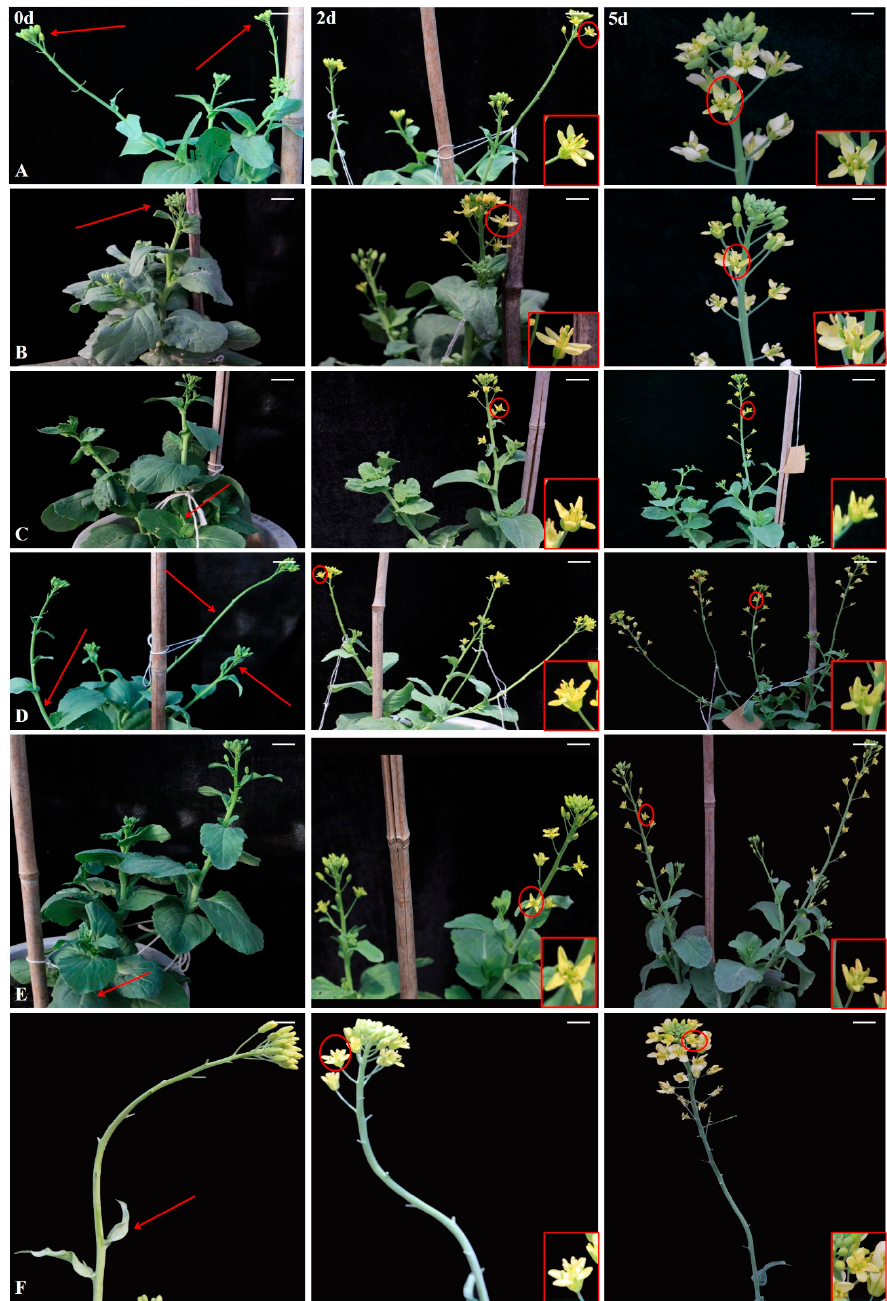
Figure 3. E ff ects of JA treatment on di ff erent tissues and parts of pdm plants. Phenotypes of Figure 3. Effects of JA treatment on different tissues and parts of pdm plants. Phenotypes of ( A ) ( A ) inflorescences, ( B ) petals, ( C ) vegetative stems. ( D ) Di ff erent parts of branches. ( E ) Basal leaves and inflorescences, ( B ) petals, ( C ) vegetative stems. ( D ) Different parts of branches. ( E ) Basal leaves and ( F ) leaves on branches before (0 d) and after treatment (2 and 5 d) are shown. The arrows indicate the positions at which JA (1 mM) was